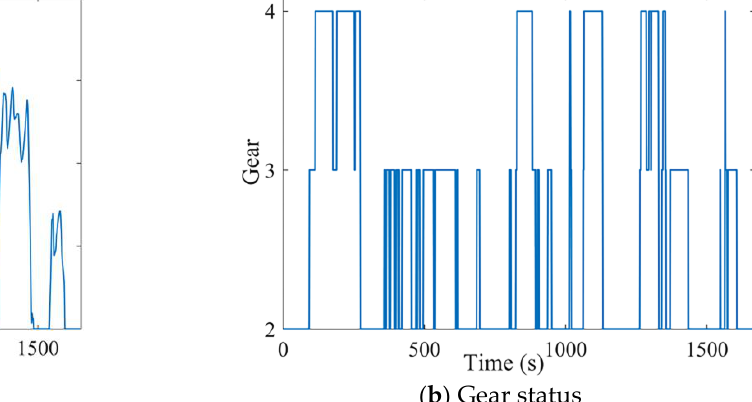
Figure 9. WVUSUB working condition.